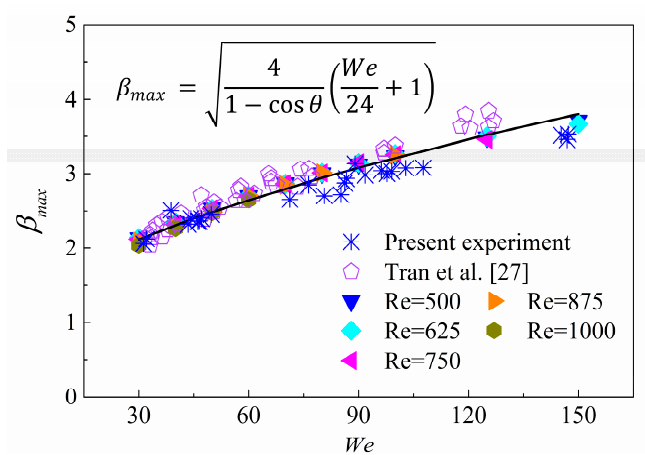
Figure 5. Comparison between the present experimental results (denoted by the stars), Tran et al.’s experimental results (denoted by the pentagon symbols) [27] and numerical predictions (denoted by the solid symbols) and the Wildeman et al.’s model (denoted by the solid line) for dimensionless droplet maximum spreading diameter β max under large Weber numbers ( We ≥ 30 ). Table 1. Summary of cited and current experiment